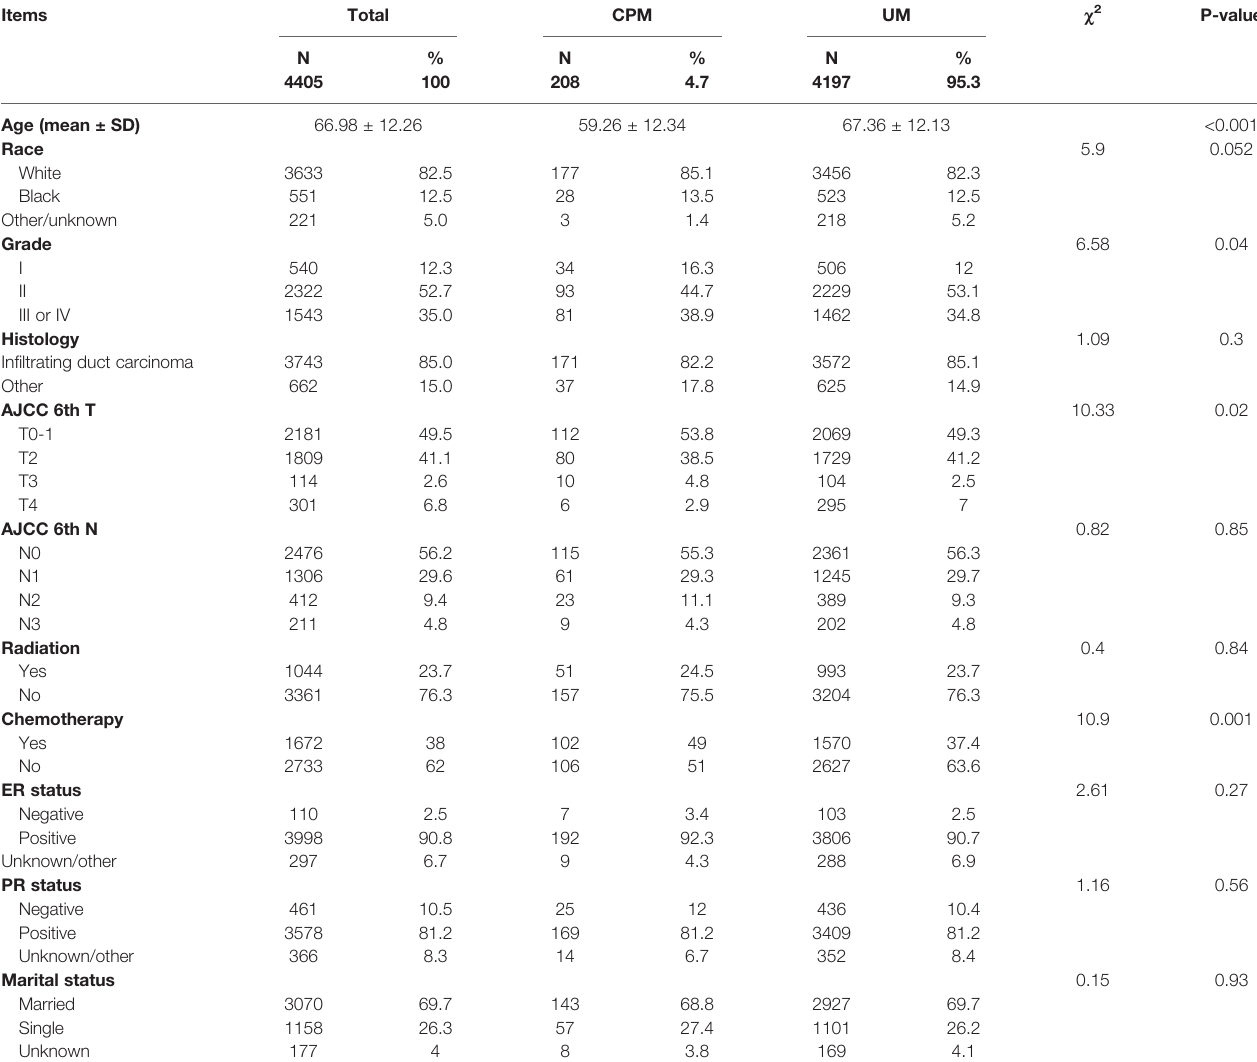
TABLE 1 | The baseline characteristics of patients with different surgery procedures in the SEER database. Items Total CPM UM c 2 P-value